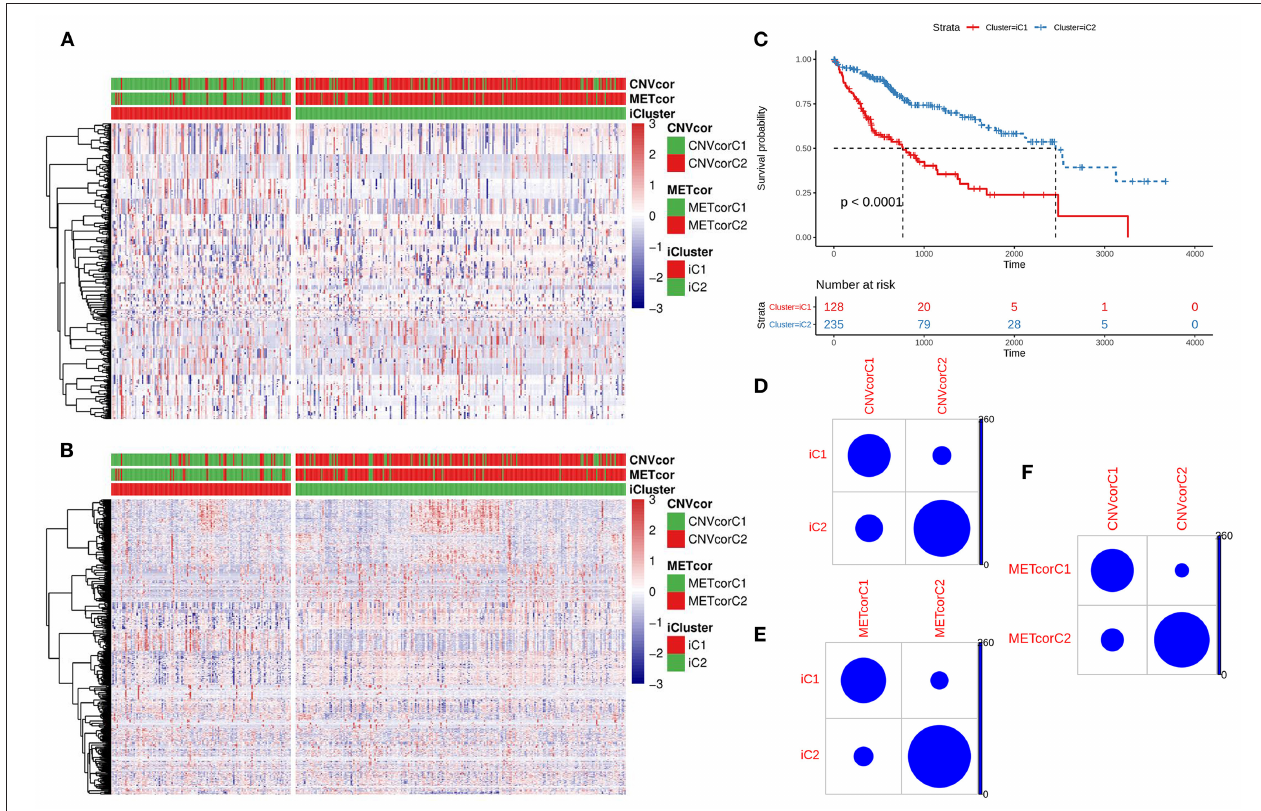
FIGURE 4 | Multi-omics clustering analysis of CNV, DNA methylation and mRNA expression. (A) iCluster clustering heat map showing the CNV distribution of CNVcor genes. (B) iCluster clustering heat map showing the methylation site distribution of METcor genes. (C) Kaplan-Meier survival analysis results for two subtypes. (D) Intersection of NMF and iCluster CNVcor gene sets. (E) Overlap between NMF METcor gene subsets and iCluster METcor subsets. (F) Overlap between iCluster METcor gene subsets and iCluster CNVcor gene